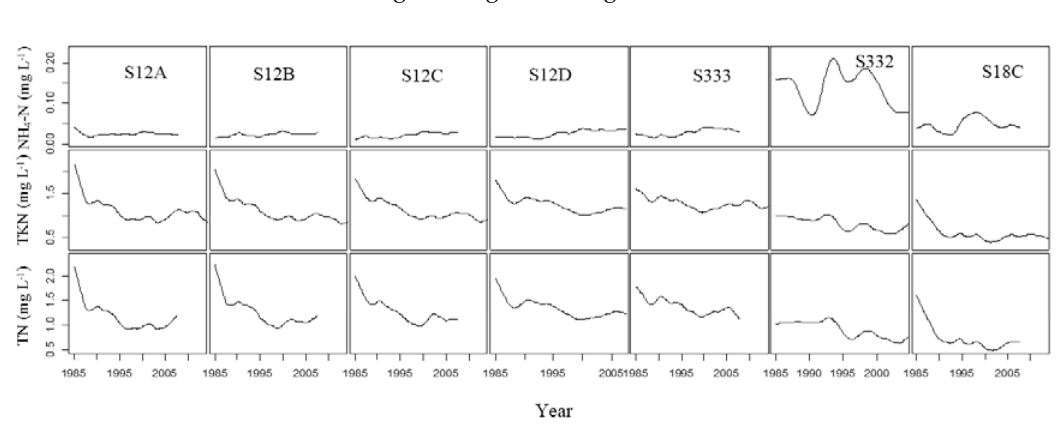
Figure 3. Trend changes in NH 4 –N, TKN, and TN at seven stations.